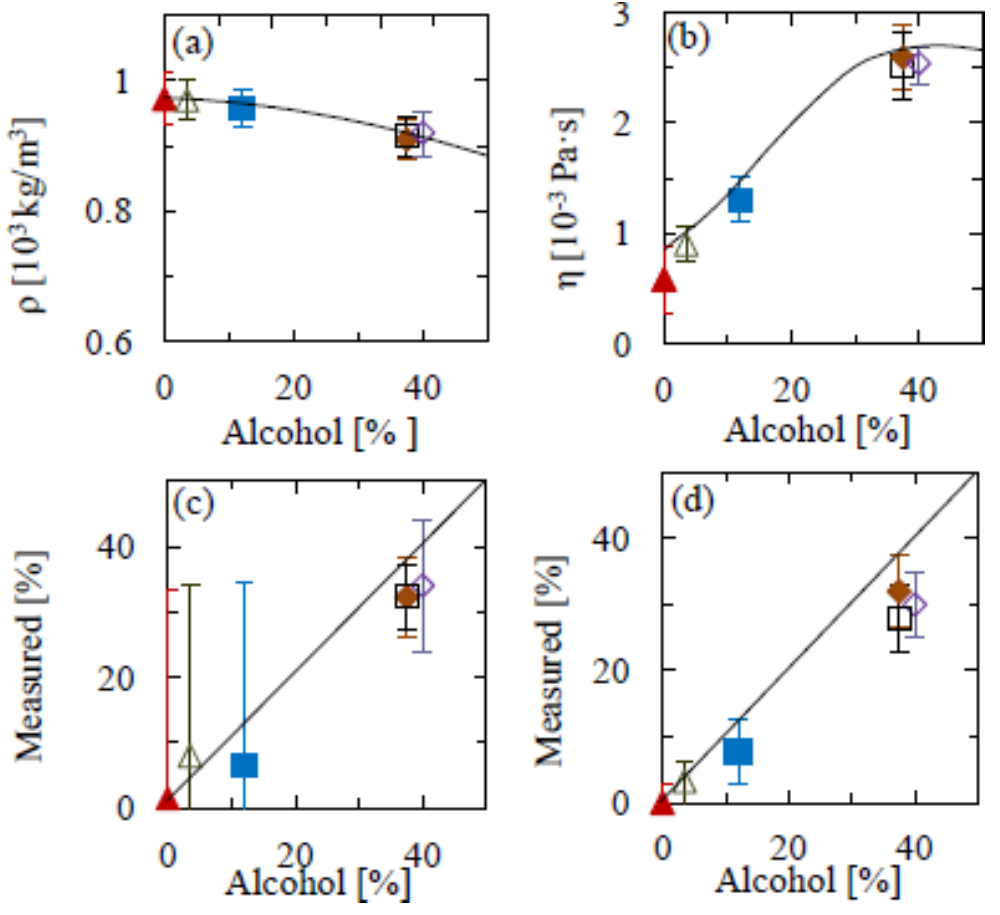
Figure 4. ( a ) Measured mass density and ( b ) viscosity of commercial beverages as a function of specified alcohol content. ( c ) and ( d ): Alcohol percentage determined from the measured mass density ( c ) and viscosity ( d ) as a function of specified alcohol content. Symbols: triangle—non-alcoholic beer; open triangle—3.5% beer; square—12.5% white wine; open square—37.5% gin; diamond—37.5% vodka; open diamond—40% whisky. Solid lined denotes interpolated water/ethanol data from Figure